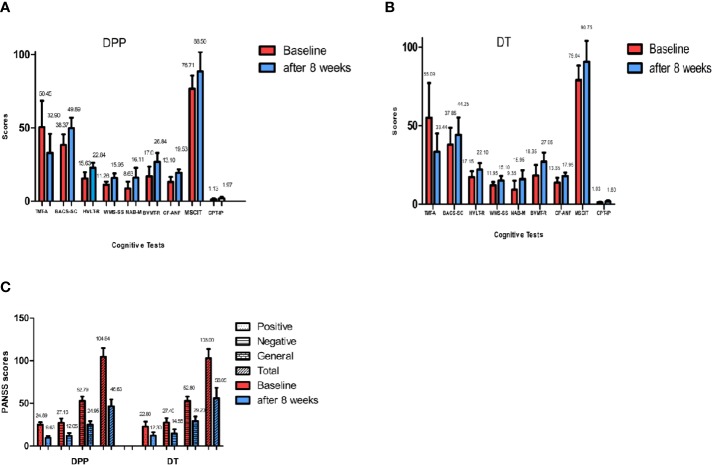
PANSS and cognitive tests results across different time points. Values above histogram bars represent related group means. Bars represent related SD. PANSS, Positive and Negative Syndrome Scale; TMT-A, Trail Making Test, part A; BACS-SC, Brief Assessment of Cognition in Schizophrenia Symbol Coding Test; HVLT-R, Hopkins Verbal Learning Test-Revised; WMS-SS, Wechsler Memory Scale Spatial Span; NAB-M, Neuropsychological Assessment Battery-Mazes; BVMT-R, Brief Visuospatial Memory Test-Revised; CF-ANF, Category Fluency-Animal Naming Fluency; MSCIT, Mayer-Salovey-Caruso Emotional Intelligence Test; CPT-IP, Continuous Performance Test-identical Pairs. (A) Cognitive results across different time points in the DPP group. (B) Cognitive results across different time points in the DT group. (C) PANSS total scores and subscale scores across different time points in the two groups.